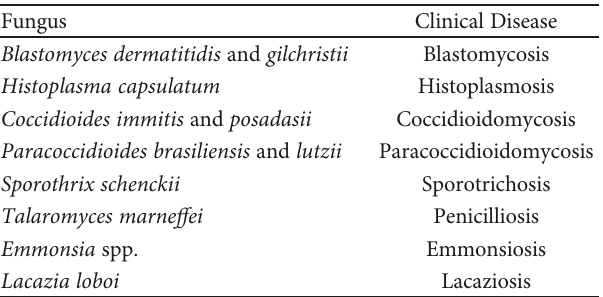
Table 1: Thermally dimorphic fungi pathogenic to humans and